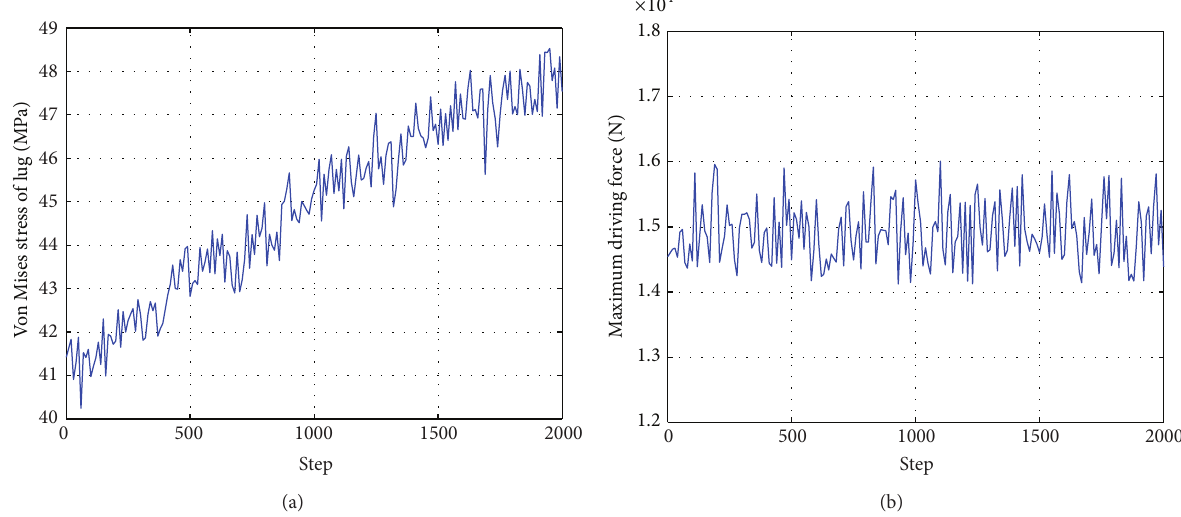
Figure 8: Time-dependent responses of stress of lug and maximum driving force. (a) Stress curve during the service life; (b) maximum driving force curve during the service life.